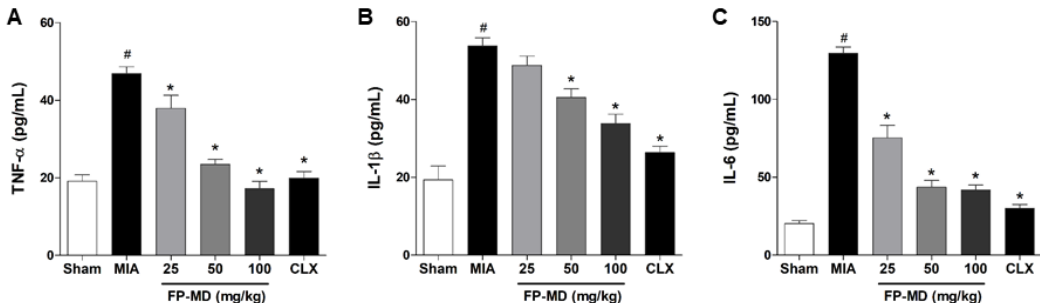
Figure 3. Effects of oral administration of FlexPro MD ® (FP-MD) on the level of tumor necrosis factor alpha (TNF- α ), interleukin (IL)-1 β , and IL-6 in monosodium iodoacetate (MIA)-induced osteoarthritis (OA) rats. The serum concentrations of ( A ) TNF- α , ( B ) IL-1 β , and ( C ) IL-6 in FP-MD (25–100 mg/kg) + MIA- or Celecoxib (CLX) (3 mg/kg) + MIA-induced OA rats were compared to those of the vehicle- treated MIA group. Data are expressed as the mean ± S.E.M ( n = 8). # p < 0.05 versus vehicle-treated Sham group and * p < 0.05 versus MIA.